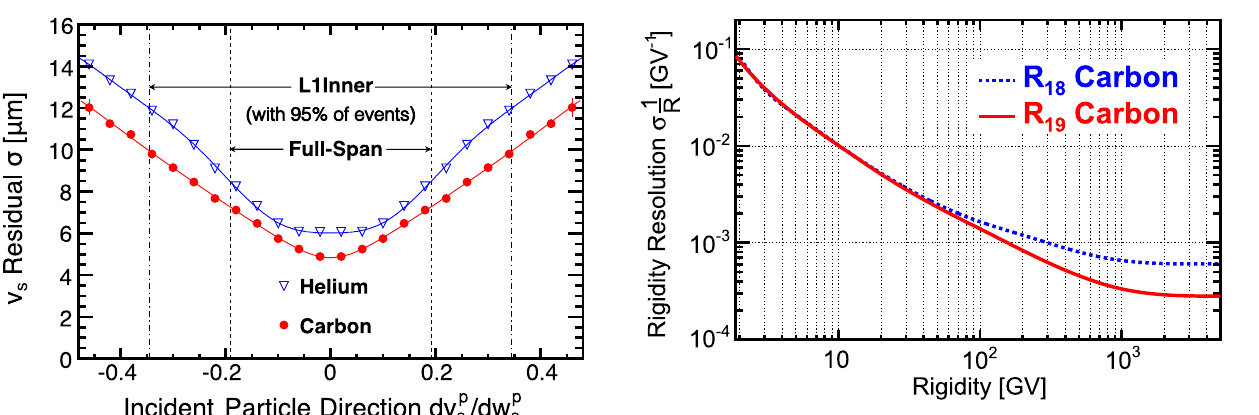
Fig. 28 The standard deviation (σ) of the v s residual (the v s coordi- nate difference between the measurement from a sensor of L5 and the prediction from the track fit using the other layers), as functions of the incident particle direction d v p s / d w p s for cosmic-ray helium (triangles) and carbon (full circles) nuclei with rigidities R > 50 GV. The verti- cal dashed lines indicate the angular boundary of the full-span tracker geometrical acceptance, which includes 95% of the events. The vertical dot-dashed lines indicate the same boundary but of the L1-inner tracker acceptance. The intrinsic tracker spatial resolution is predominant in the residual σ. The average v s coordinate resolutions are 6.5 (7.5) µ m for helium and 5.1 (5.8) µ m for carbon in the full-span (L1 and inner) tracker geometry